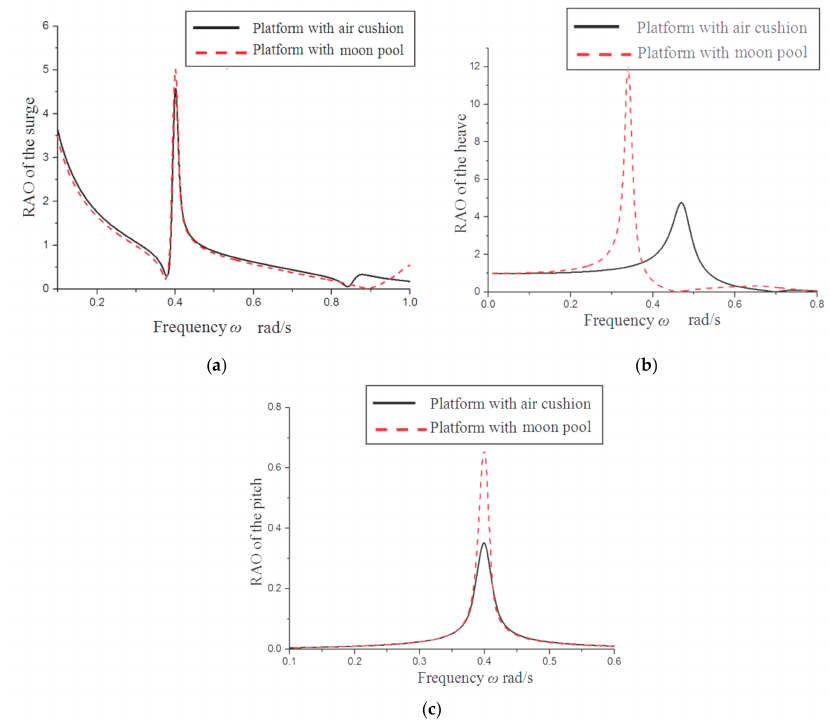
Figure 7. Comparison of RAOsbetween platform with air cushion andplatform with moon pool. ( a ) Surge RAO; ( b ) heave RAO; ( c ) pitch